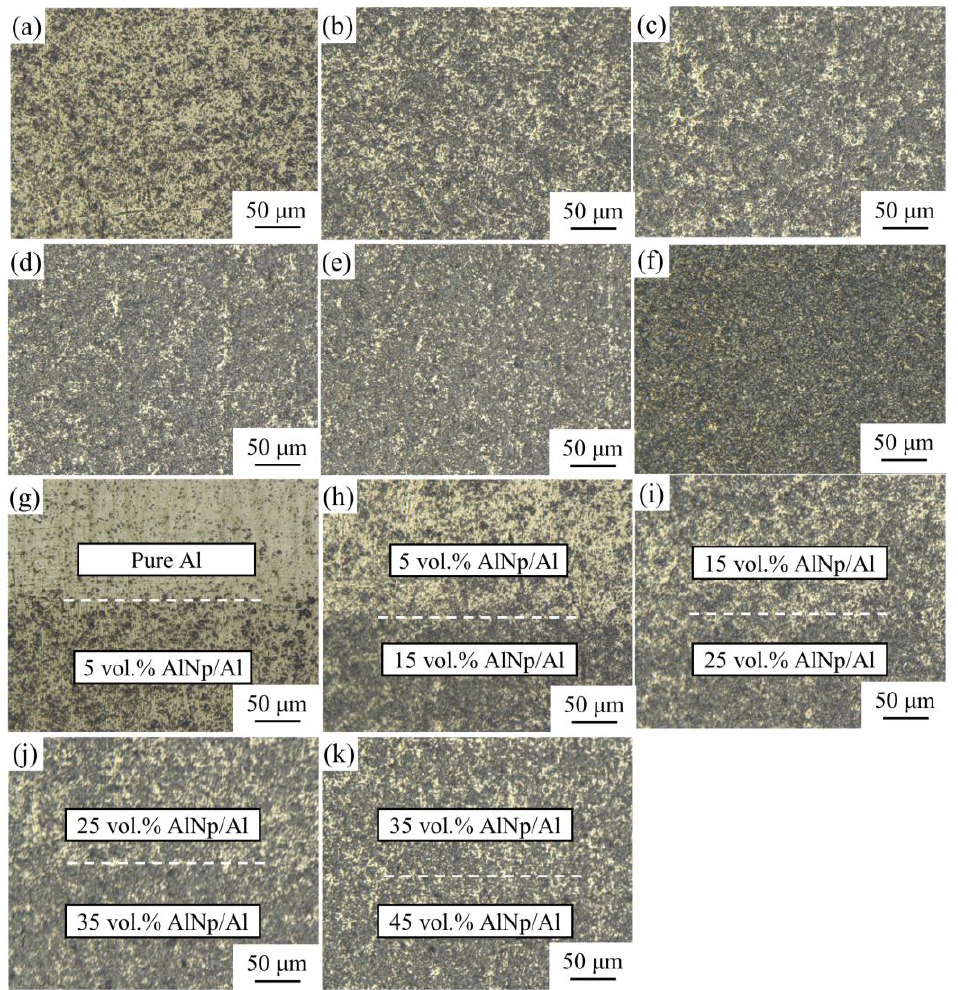
Figure 8. SEM imaging of gradient composites with different volume fraction of AlN: ( a ) 5 vol.% AlN/Al; ( b ) 15 vol.% AlN/Al; ( c ) 25 vol.% AlN/Al; ( d ) 35 vol.% AlN/Al; ( e ) 45 vol.% AlN/Al; and ( f ) 55 vol.% AlN/Al; SEM photomicrographs of layer regions: ( g ) Pure Al – 5 vol.% AlN/Al; ( h ) 5 – 15 vol.% AlN/Al; ( i ) 15 – 25 vol.% AlN/Al; ( j ) 25 – 35 vol.% AlN/Al; and ( k ) 35 – 45 vol.% AlN/Al.